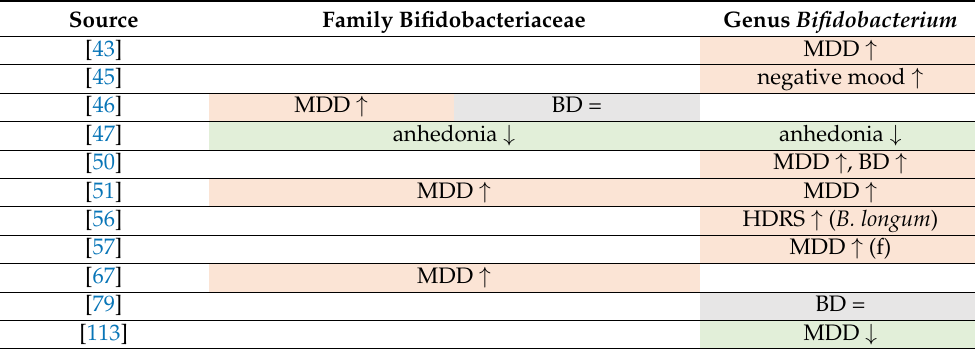
Table 6. Different abundances of family Bifidobacteriaceae and genus